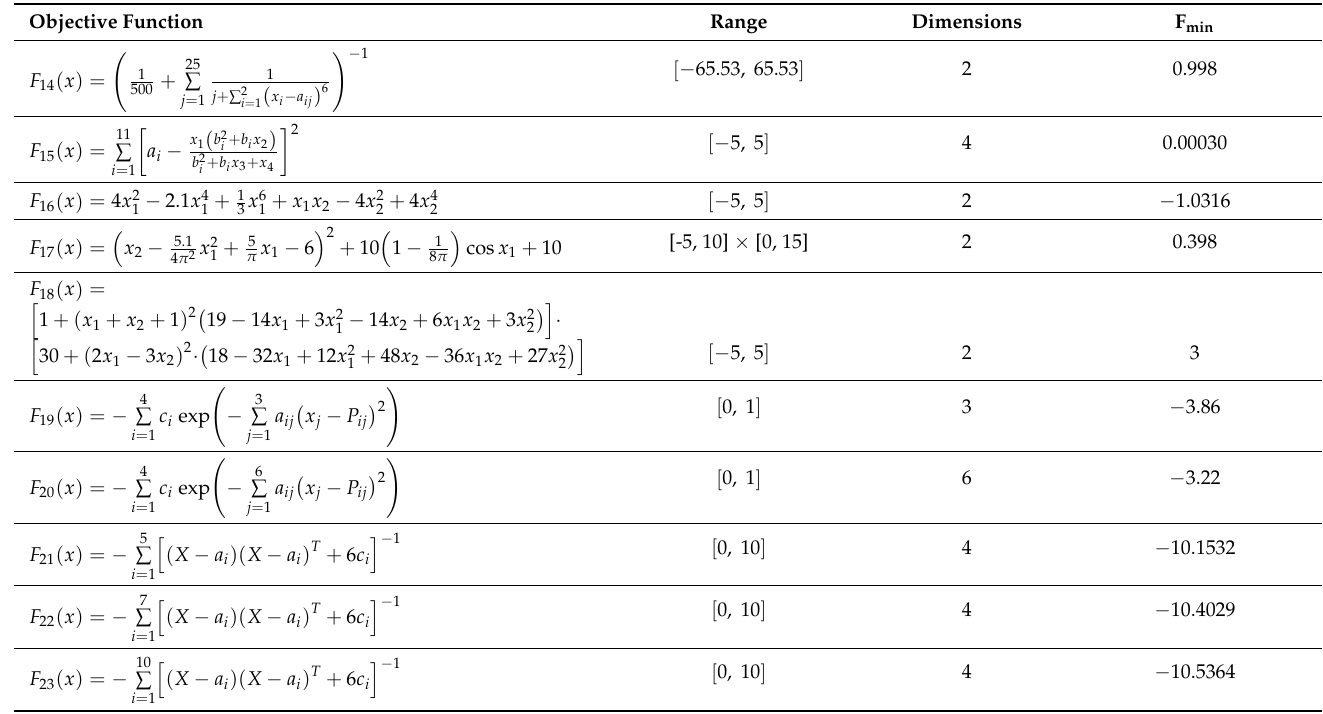
Table A3. Fixed-dimensional multimodal